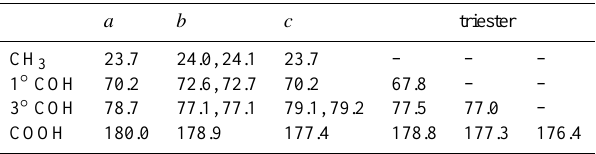
Table 3. 13 C NMR assignments for 2-MG and derivatives (in ppm, relative to DSS) for Solution 1. See Fig. 3 for key to labels of units. Tentative, partial triester assignments are given (the absence of the full complement of peaks is presumably due to overlap with 2-MG and 2-MG-diester species).